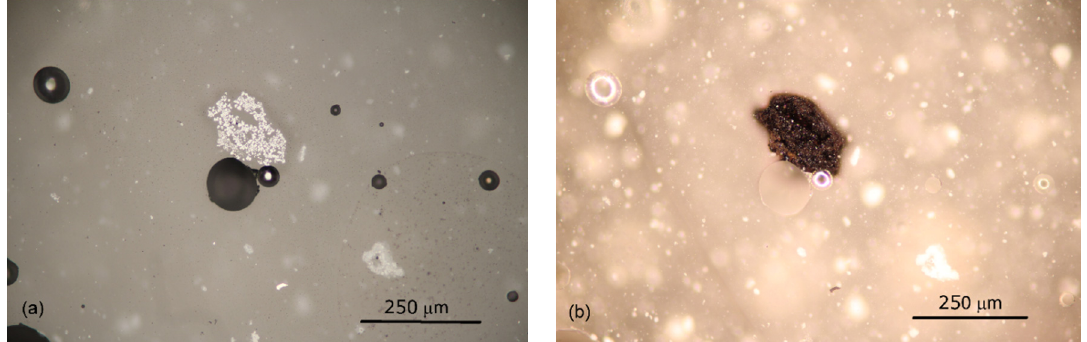
Figure 2. OM images of manganese-containing inclusions of tessera PD-NC2. Note that they appear greyish white with a medium reflectance in BF illumination ( a ) and dark brown in colour in DF illumination ( b ). This is the same for all the tesserae with these kinds of inclusions.